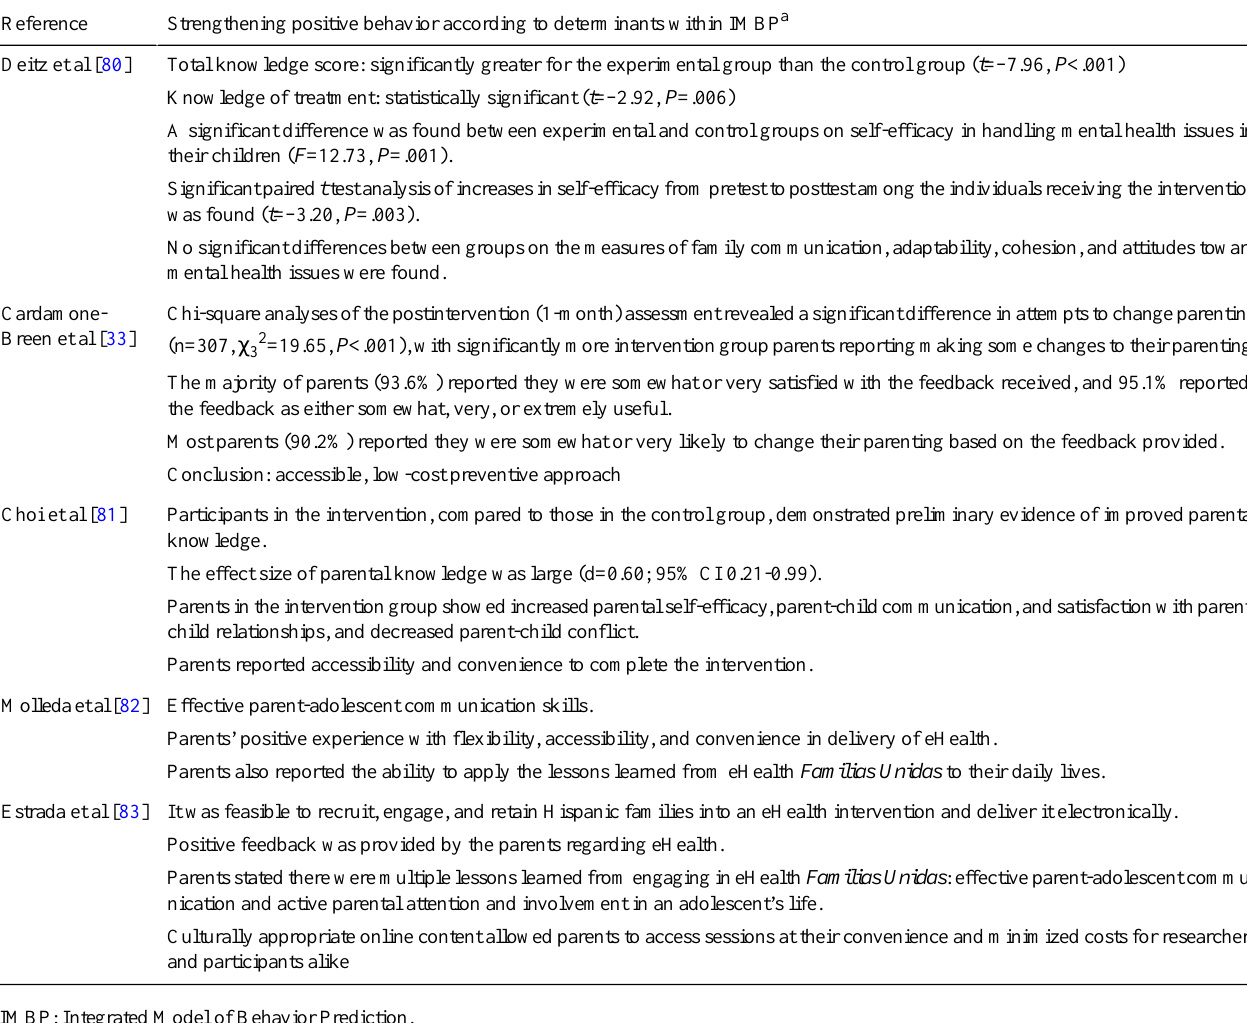
Table 4. Summary of results reported by the 5 articles. Strengthening positive behavior according to determinants within IMBP a